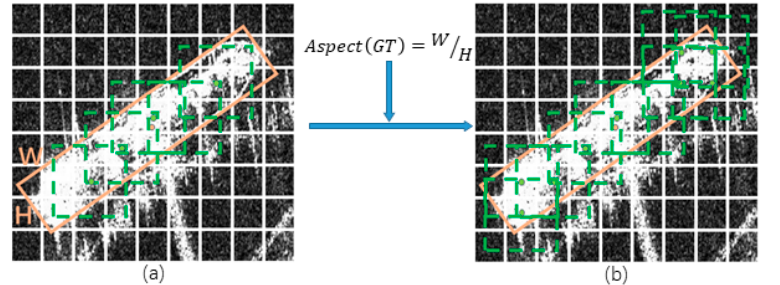
Figure 8. Comparison illustration of two IoU thresholds. ( a ) The positive sample allocation results of the ATSS. ( b ) The positive sample allocation results of the new adaptive IoU threshold with the aspect ratio. The green square boxes represent positive samples, and the green points represent their center points.